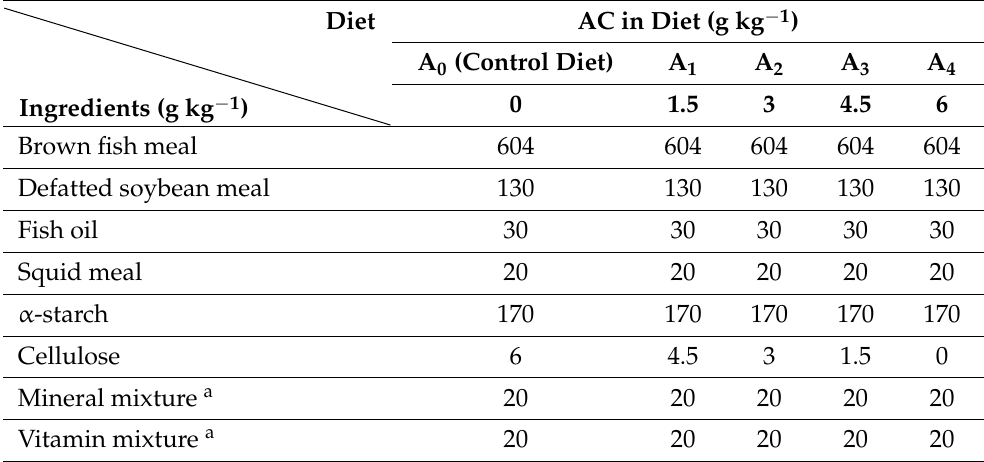
Table 1. Composition of the basal diet (g kg − 1 ) for orange-spotted grouper ( Epinephelus coioides